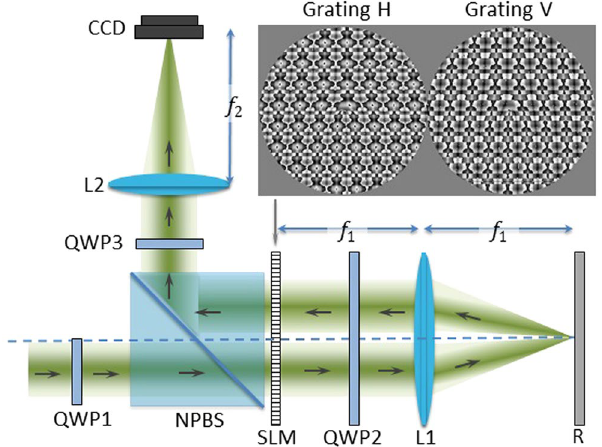
Figure 1. Experimental system. SLM: parallel-aligned spatial light modulator. QWP: quarter-wave plate. L: converging lens. NPBS: non-polarizing beam-splitter. R: mirror. The SLM displays two phase-only gratings with embedded spiral phases (shown in the insert) that are encoded on two orthogonal states of